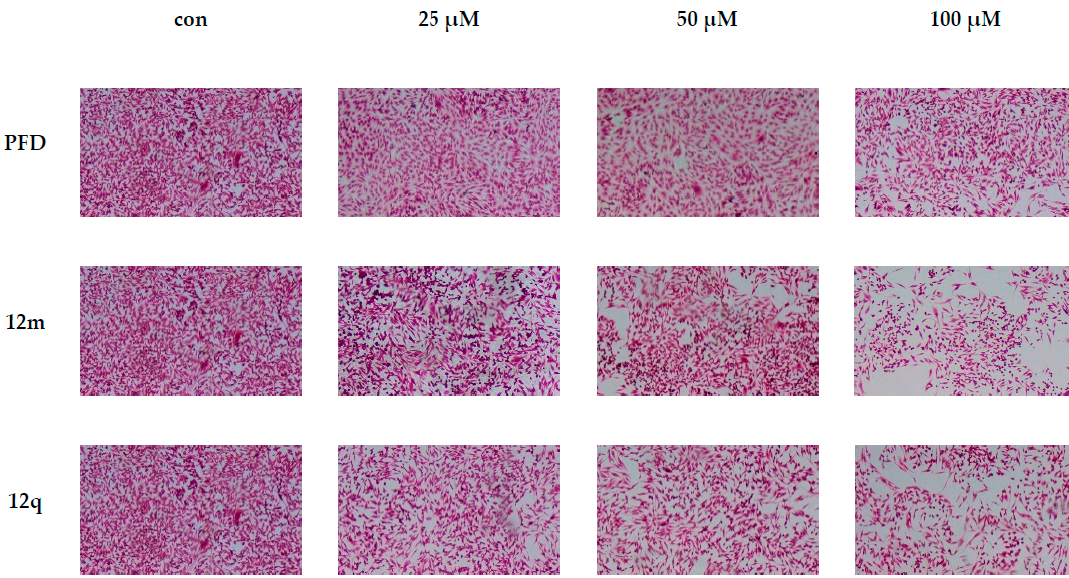
Figure 4. The effect of PFD , 12q and 12m on the expression of collagen α 1 in HSC-T6 cell line. 3. Experimental Section 3.1. General Information All commercial reagents were used as received without additional purification. The melting point was uncorrected. Mass spectra were obtained using the electro spray ionization (ESI) method. The 1 H and 13 C Nuclear Magnetic Resonance (NMR) data were obtained on a 300 MHz NMR spectrometer (Bruker, Rheinstetten, Germany) with tetramethylsilane (TMS) as the internal standard, using Chloroform-d (CDCl 3 ) , DMSO-d 6 as solvents. All the NMR spectra can be found in